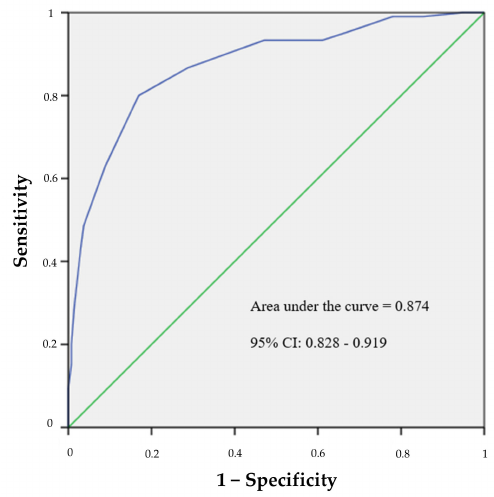
Figure 4. Receiver operator characteristic curve of the CVS-Q